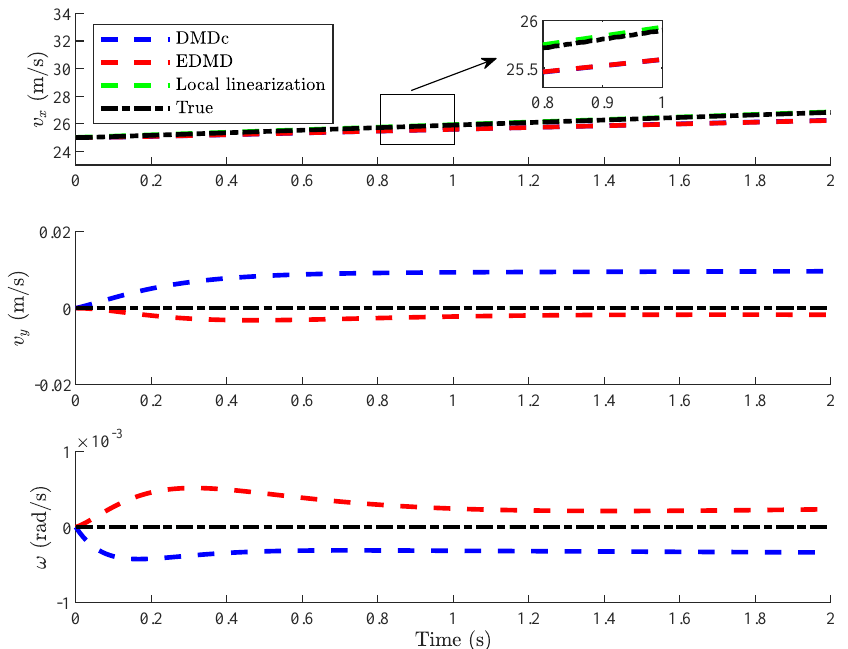
Figure 8. Validation of the Koopman linear model (Scenario 1).